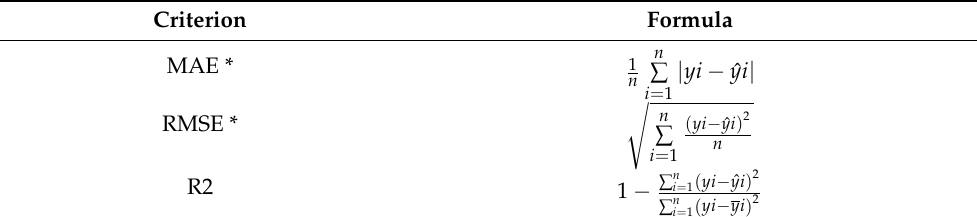
Figure 7. RMSE for 10-fold cross-validation of the random forest (RF) model.